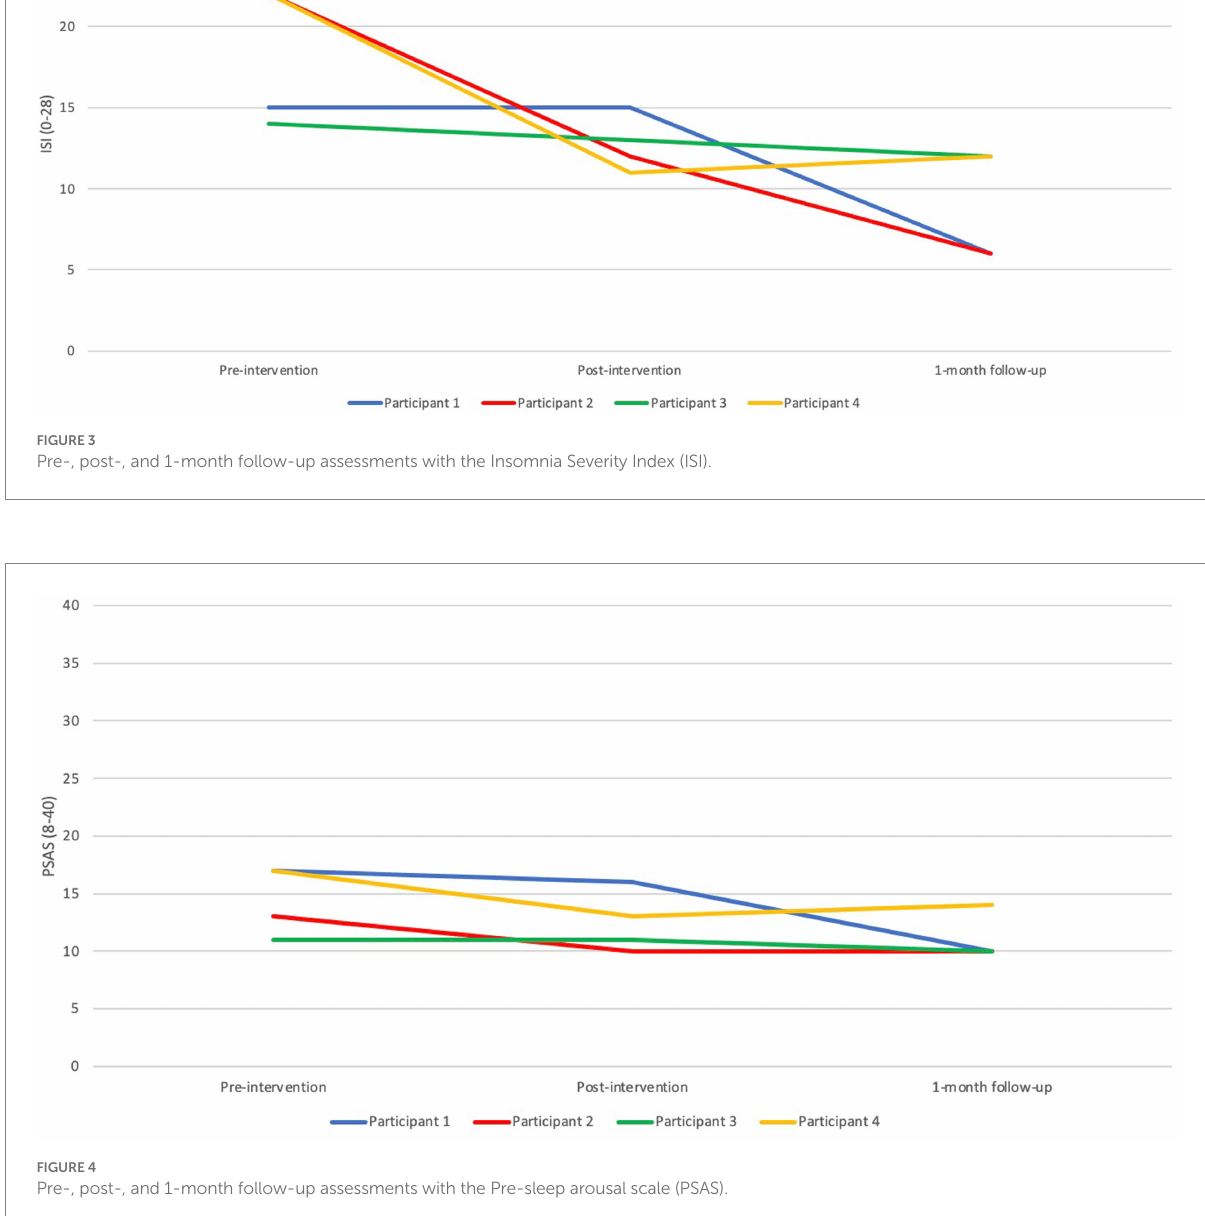
FIGURE 4 Pre-, post-, and 1-month follow-up assessments with the Pre-sleep arousal scale